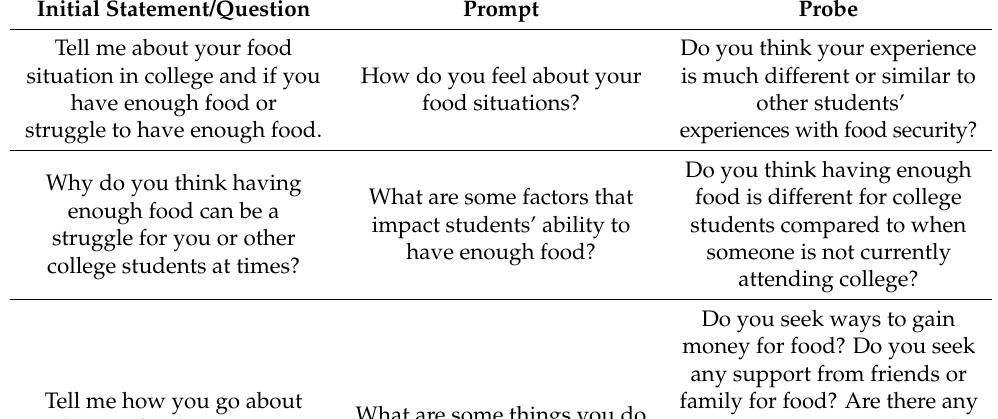
Table 1. Focus Group Guide: Initial Statements/Question and Subsequent Prompt and